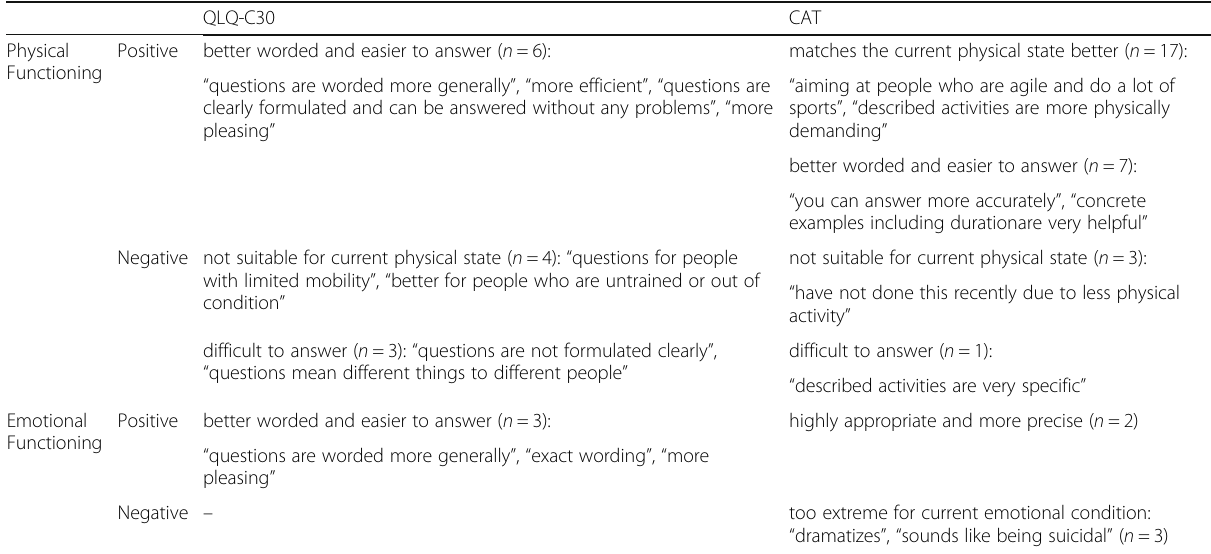
Table 4 Results from cognitive interview think-aloud sessions